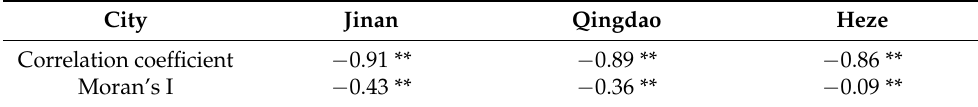
Table 3. CIS and CID correlation coefficient and bivariate Moran’s I